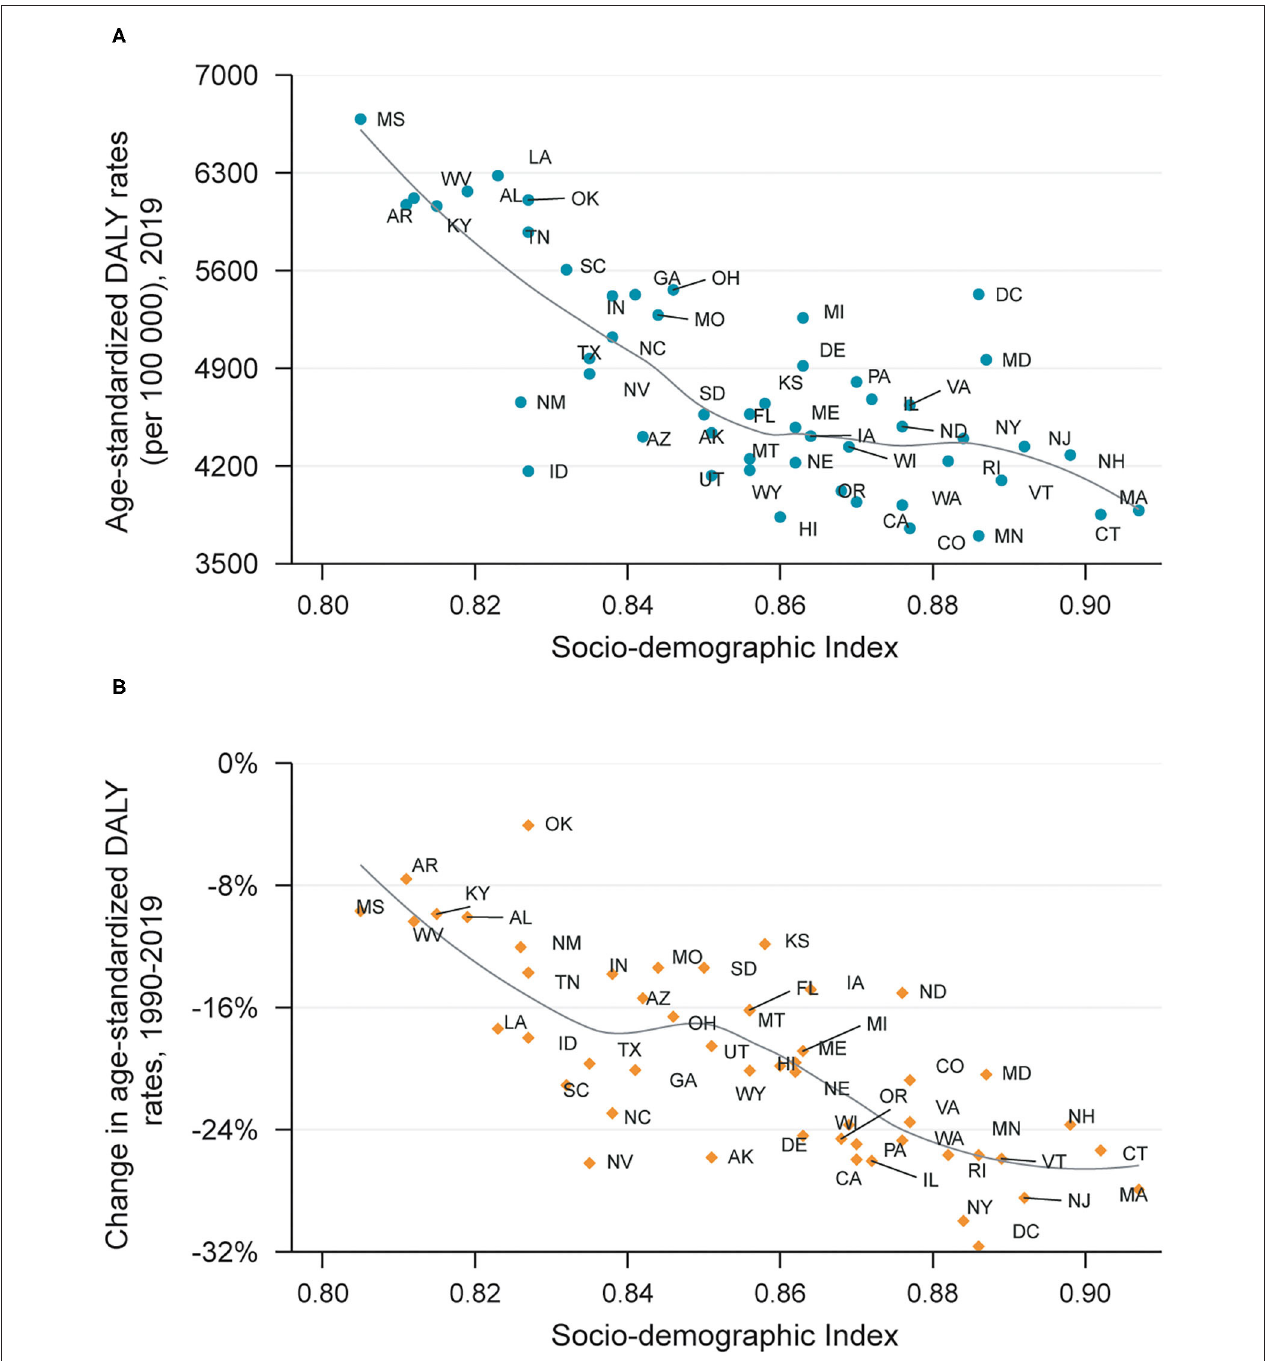
FIGURE 4 | DALYs (A) and its changes (B) attributable to metabolic risk factors by SDI, 1990–2019.